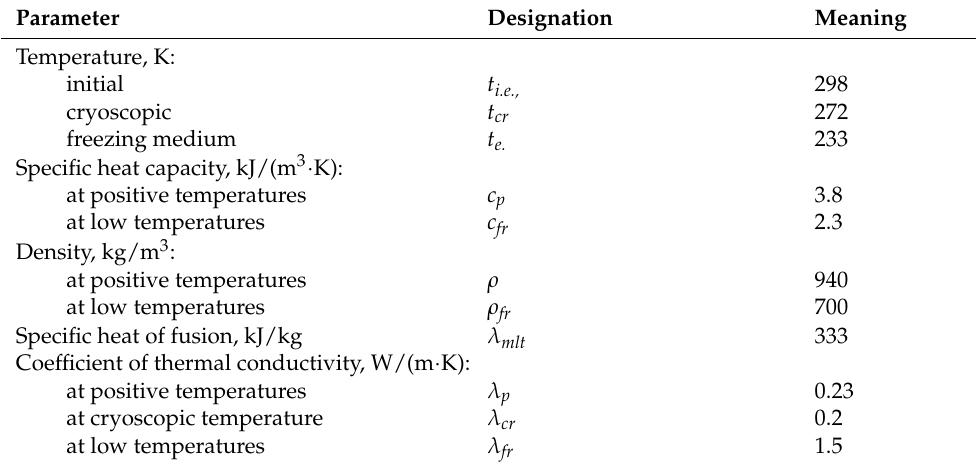
Table 1. Thermophysical characteristics of squash.